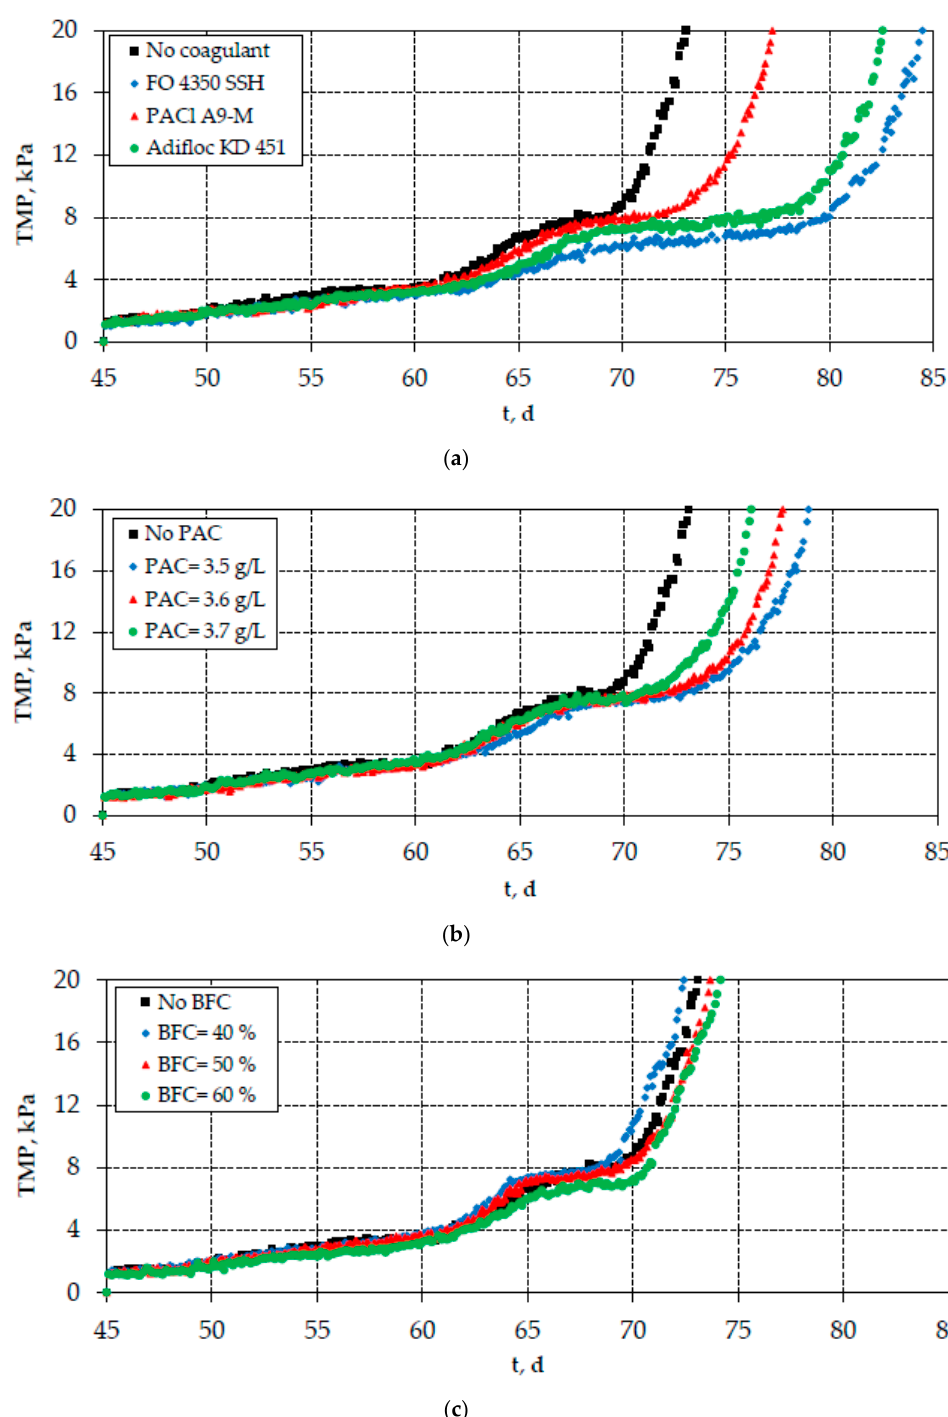
Figure 6. Evolution of trans-membrane pressure (TMP) in the mixed liquor after the addition of (a) optimal coagulation agents FO 4350 SSH (10 mg/L), PACl A9-M (100 mg Al/L), and Adifloc KD 451 ( a ) optimal coagulation agents FO 4350 SSH (10 mg / L), PACl A9-M (100 mg Al / L), and Adifloc KD 451 (10 mg/L); (b) optimal PAC concentrations (3.5–3.7 g/L), and (c) bio-film carriers (40%, 50%, and 60%). (10 mg / L); ( b ) optimal PAC concentrations (3.5–3.7 g / L), and ( c ) bio-film carriers (40%, 50%, and